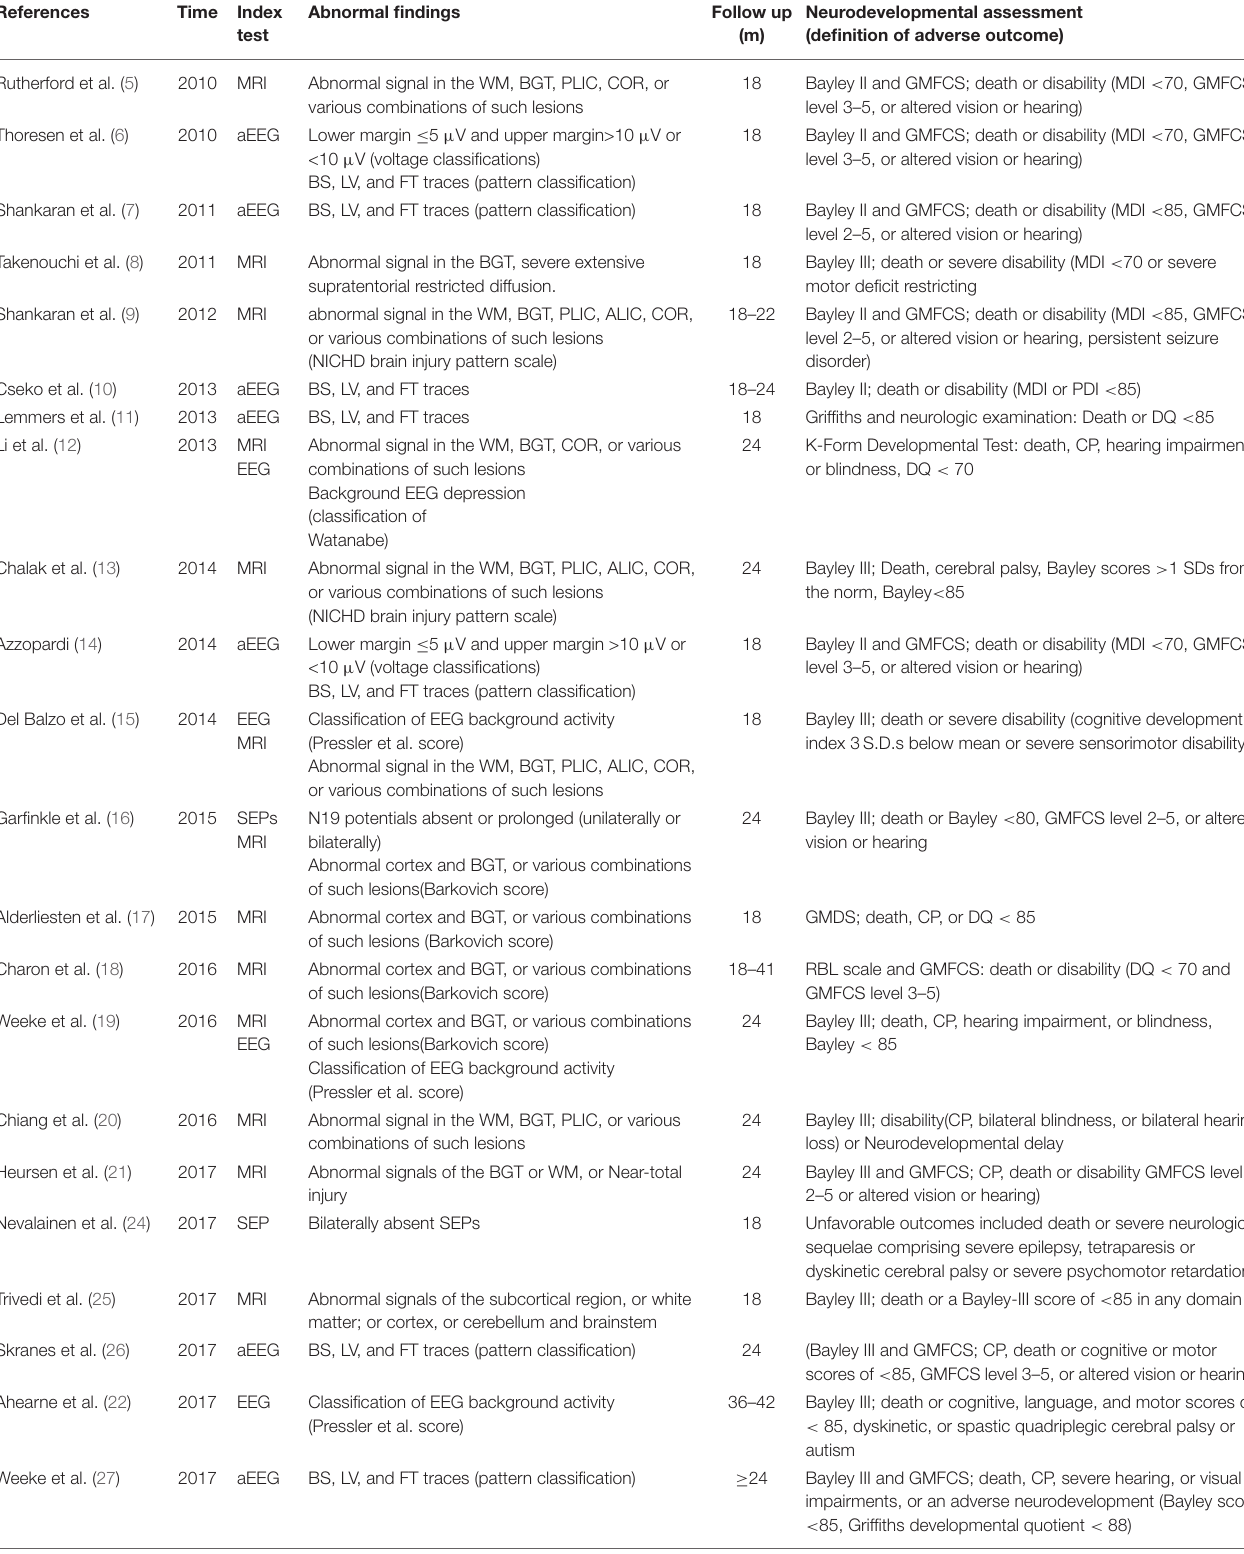
TABLE 2 | Neurological outcomes defined by